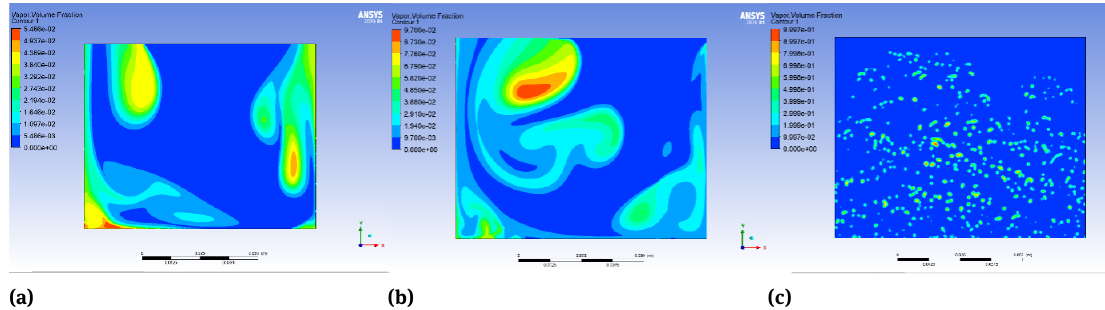
Figure 7: Volume fraction in 5 s. (a) Eulerian; (b) mixture; (c) VOF